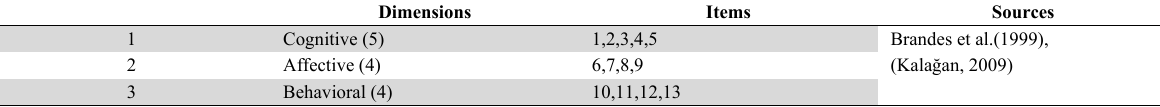
Measuring Organizational Cynicism